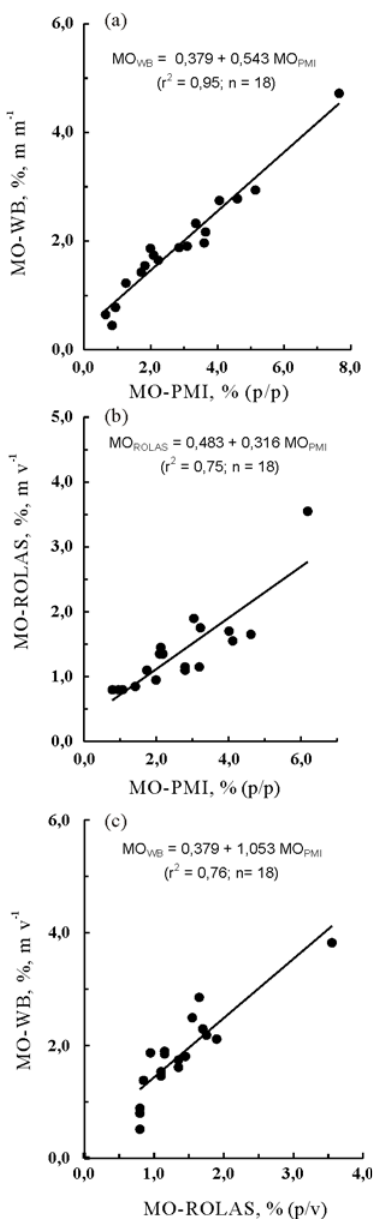
Figura 1. Relação entre os teores de matéria orgânica (MO) determinada com os métodos Walkley- Black (WB), perda de massa por ignição (PMI) e solução sulfocrômica (ROLAS), em amostras de solos de diversas unidades de mapeamento do Rio Grande do